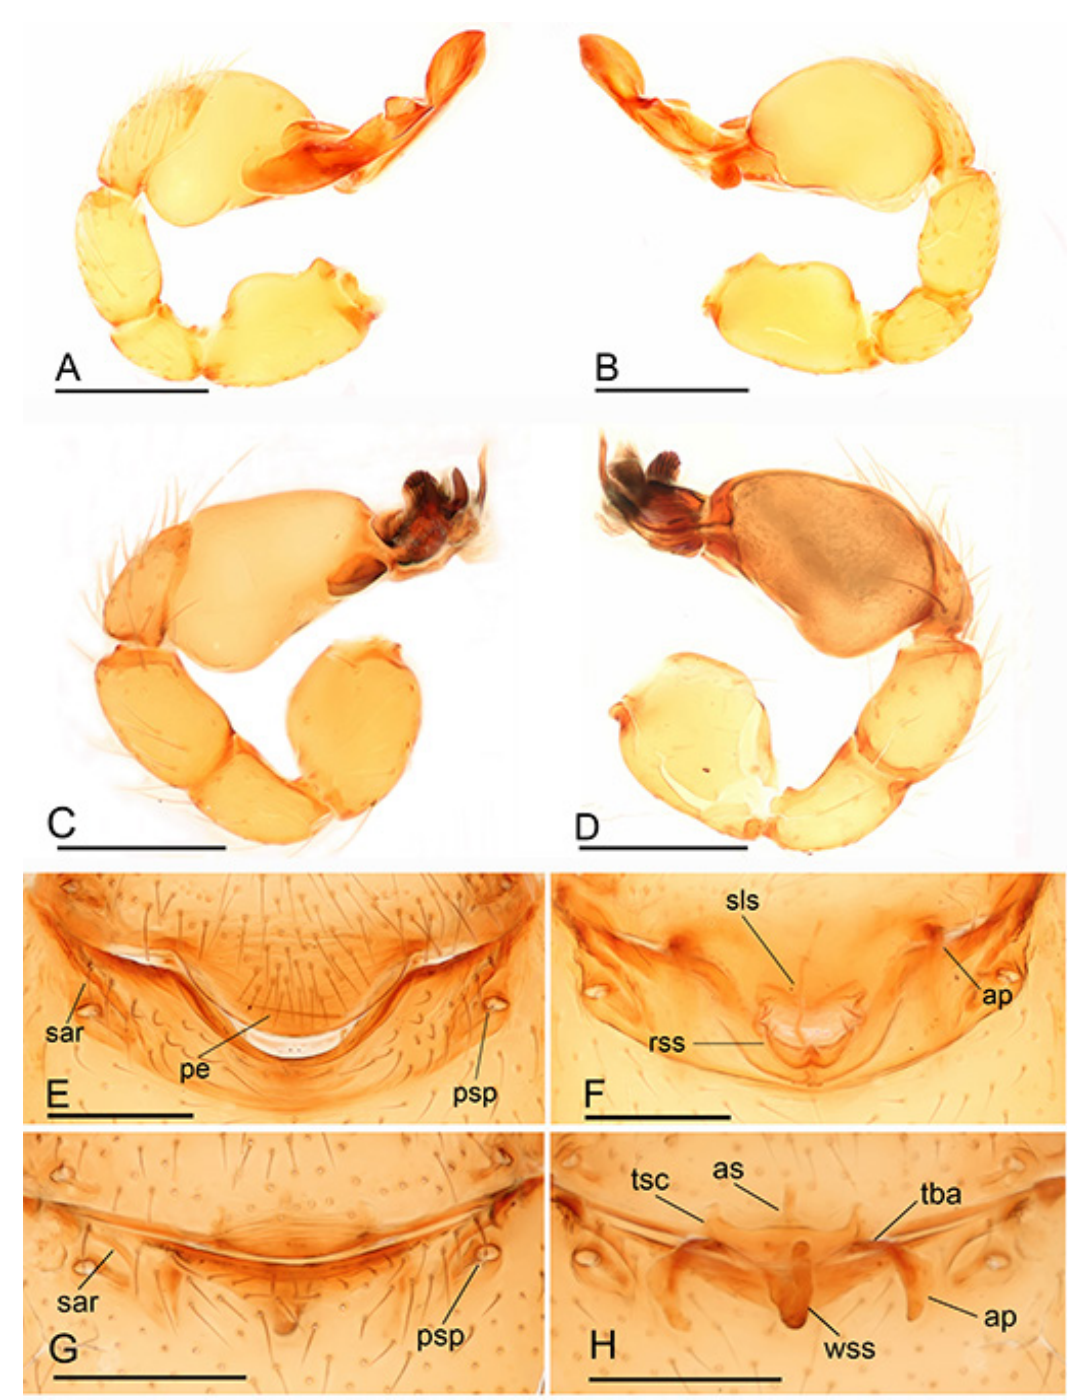
Fig. 4. A – B . Trilacuna jinyun Tong, Zhang & Li sp. nov., holotype, ♂ (SYNU-291). C – D . T. jiuchi Tong, Zhang & Li, sp. nov., holotype, ♂ (SYNU-300). E – F . T. jinyun sp. nov., paratype, ♀ (SYNU- 292). G – H . T. jiuchi sp. nov., paratype, ♀ (SYNU-303). A, C. Left palp, prolateral view. B, D. Left palp, retrolateral view. E, G. Epigaster, ventral view. F, H. Endogyne, dorsal view. Abbreviations: ap = apodeme; as = anterior sclerite; pe = posterior extension; psp = posterior spiracle; rss = rectangular shaped structure; sar = sclerotized, recurved arches; sls = slender line-like structure; tba = transverse bars; tsc = transverse sclerite; wss = worm-shaped structure. Scale bars: 0.2